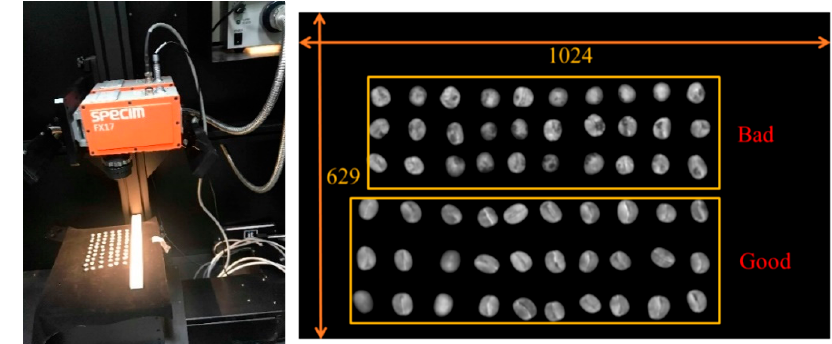
Figure 2. Filming of coffee beans.